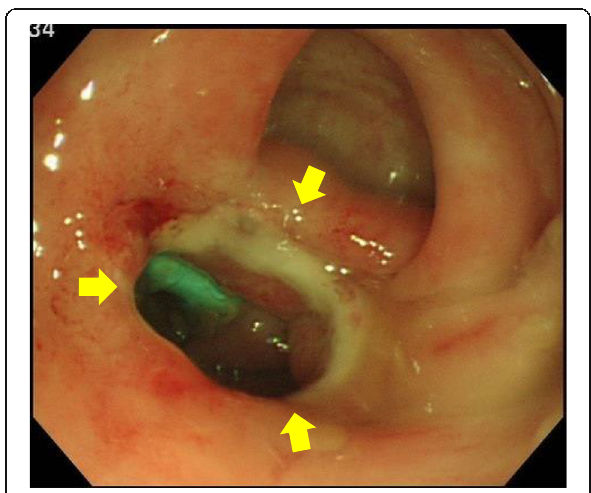
Fig. 5 Anastomosis observed by colonoscopy immediately after the magnets were dropped